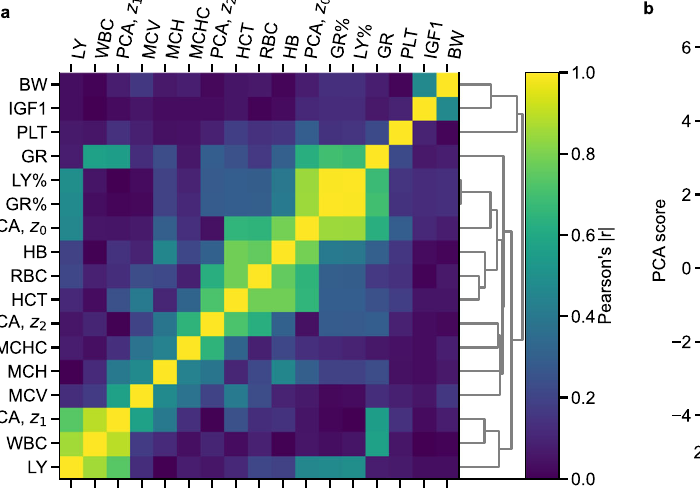
Fig. 1 | Hierarchical clustering and Principal Component (PC) Analysis of complete blood count (CBC) measurements from The Mouse Phenome Data- base. a Clustering of CBC features and PC scores in the training dataset. The colors represent Pearson ’ s correlation coef fi cient (absolute value) as indicated by the scale